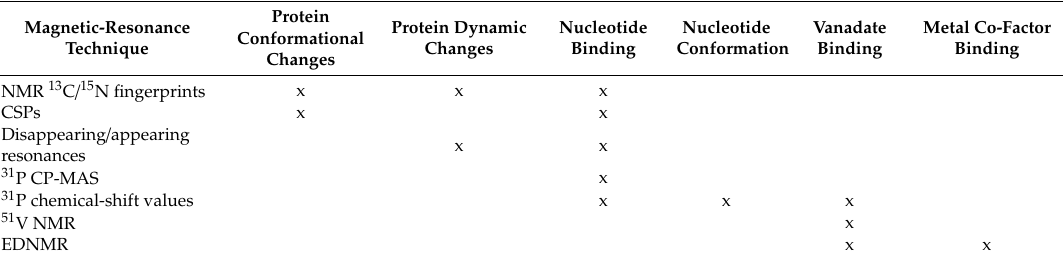
Table 1. Overview of magnetic-resonance techniques applied in this work and information extracted. A cross indicates that this information is contained in the experimental outcome, a blank indicates that the type of extracted information is not accessible by the